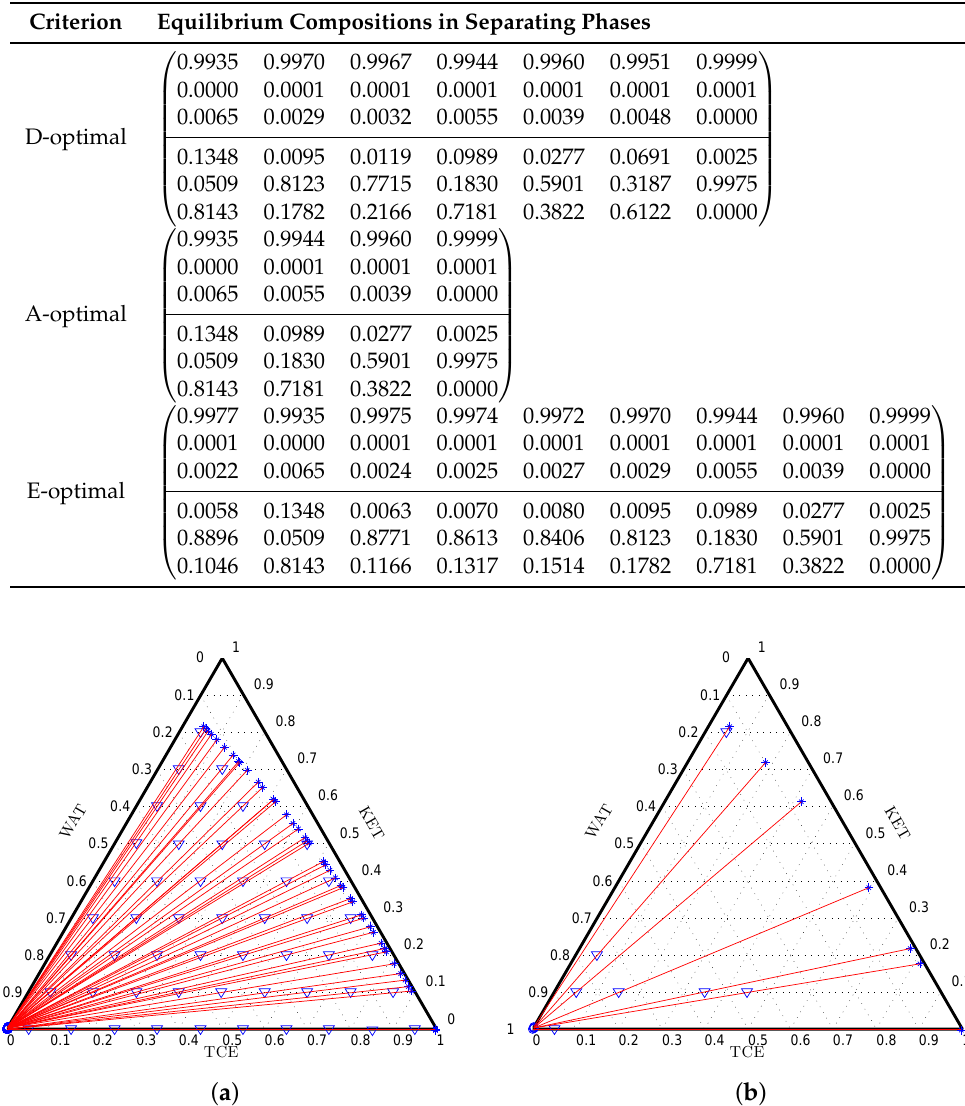
Figure 2. D-optimal designs for system WAT-TCE–KET: ( a ) candidate initial mixtures and corresponding tie-lines; and ( b ) tie-lines corresponding to D-optimal design (symbols: o, Phase 1 composition; ∗ , Phase 2 composition; (cid:79) , initial mixture composition; tie lines in